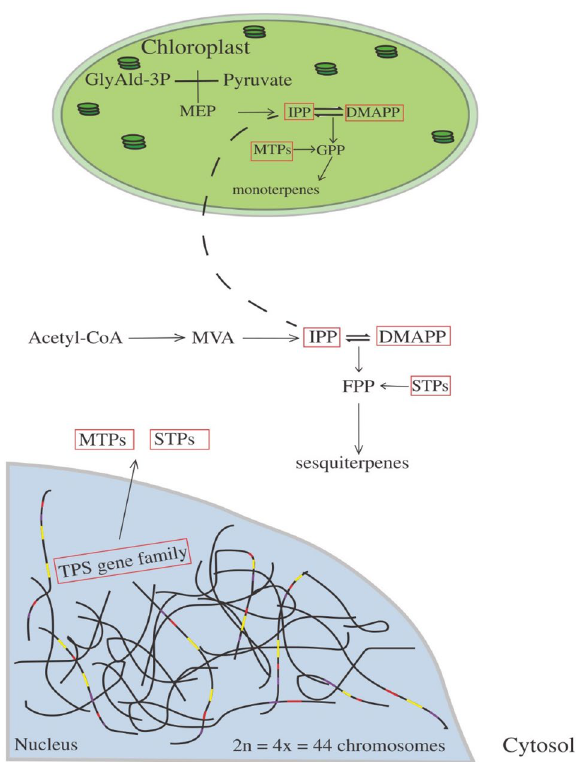
Figure 4. Hypothetical scheme of the terpene pathway in E. benthamii autotetraploids. Solid arrows indicated multiple enzymatic and transport steps. Red boxes indicate the role of chromosome set doubling in terpene biosynthesis. Long dashes represent the possible crosstalk between cytosol and chloroplast of the precursor IPP. MTPs are imported to chloroplast and use the MEP products (IPP and GPP) to form the major monoterpenes. STPs use the MVA products (IPP and FPP) to create sesquiterpenes in cytosol. Abberviations: TPS, terpene synthase gene family; MTPs, monoterpene synthases; STPs, sesquiterpene synthases; MVA, mevalonic acid; IPP, isopentenyl diphosphate; DMAPP, dimethilallyl diphosphate; FPP, farnesyl diphosphate; GPP, geranyl diphosphate; MEP, methylerythritol 4-phosphate; GlyAld-3P, glyceraldehyde